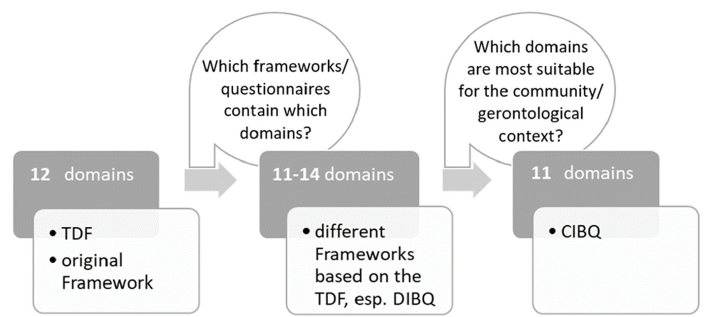
Figure 1. Adaption and selection process of the discussed domains. TDF = Theoretical Domains Framework; DIBQ = Determinants of Implementation Behavior Questionnaire; CIBQ = Community Implementation Questionnaire.